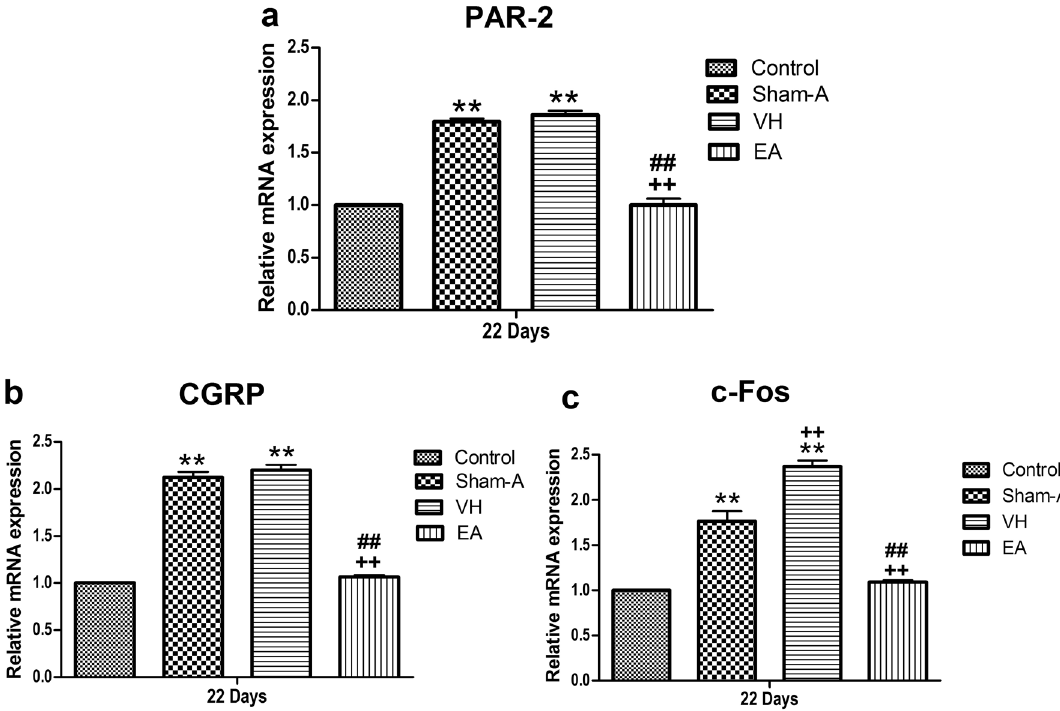
Figure 6. Cumulative effects of repetitive EA stimulations on the mRNA expressions of PAR-2 (a), CGRP (b) and c-Fos (c) in the spinal cord of the goats (Mean ± SD, n = 6). Quantitative real-time PCR (qRT-PCR) was performed to measure the mRNA e xpressions of PAR-2, CGRP and c-Fos (relative to GAPDH) in T 11 thoracic spinal cord dorsal horns. ( a ) PAR-2 mRNA; P = 0.000, Sham-A or VH group versus Control group; P = 0.000, VH group versus Sham-A group; P = 0.000, EA group versus VH group [F (3, 20) = 675.15, P = 0.000]. ( b ) CGRP mRNA; P = 0.000, Sham-A or VH group versus Control group; P = 0.000, VH group versus Sham-A group; P = 0.000, EA group versus VH group [F (3, 20) = 1,437.07, P = 0.000]. ( c ) c-Fos mRNA; P = 0.000, Sham-A or VH group versus Control group; P = 0.000, VH group or EA group versus Sham-A group; P = 0.000, EA group versus VH group [F (3, 20) = 930.32, P = 0.000]. ** P < 0.01, VH/Sham-A/EA group versus Control group. ++ P < 0.01, VH/EA group versus Sham-A group. ## P < 0.01, VH group versus EA group. One-way ANOVA followed by Bonferroni’s post-hoc